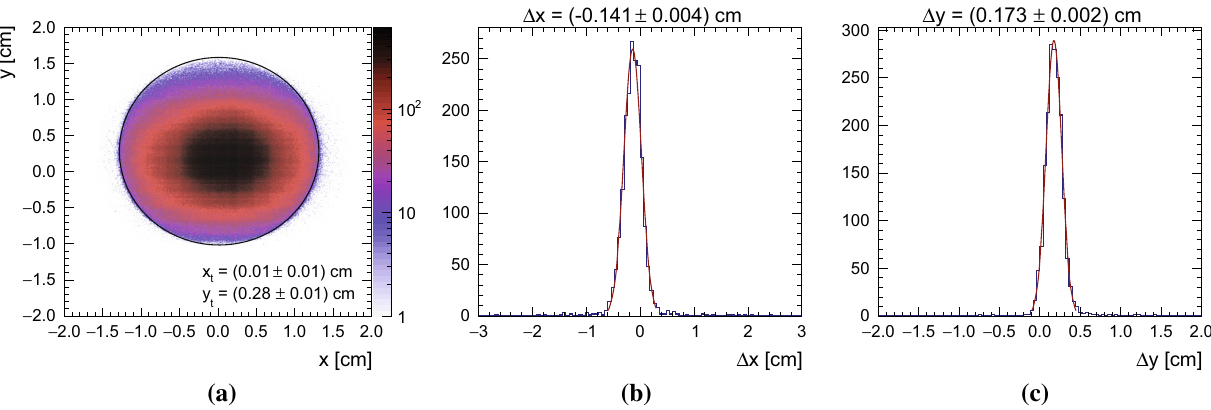
Fig. 4 Target position with respect to the BPDs: distribution of beam particles in x − y at the target upsteam face ( a ), BPD-TPC alignment in x ( b ) and BPD-TPC alignment in y ( c )